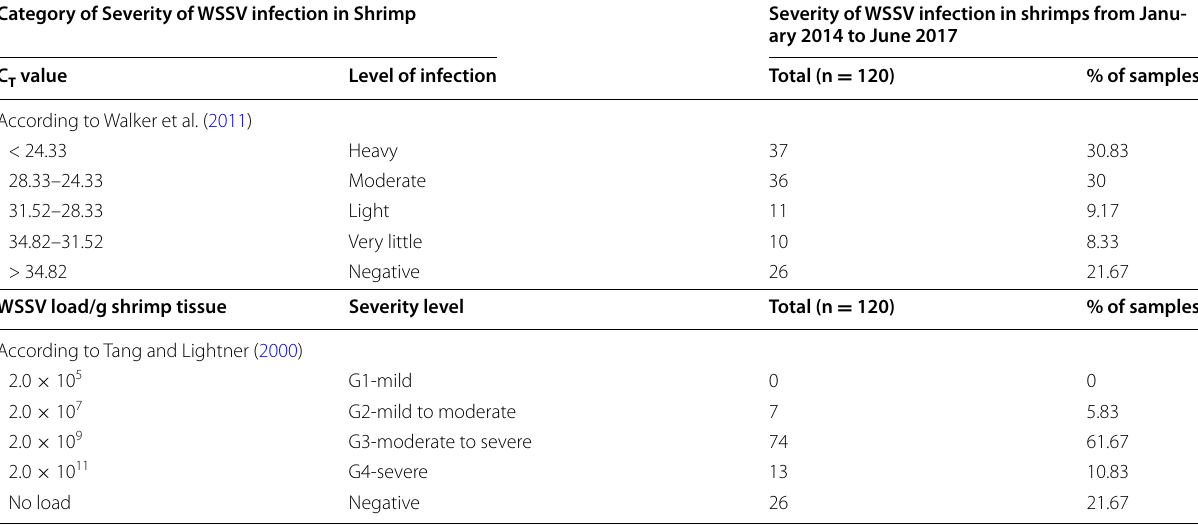
Table 1 The potential severity of WSSV infection in farmed shrimp was evaluated by the laboratory based severity study of Walker et al. (2011) and Tang and Lightner (2000) Category of Severity of WSSV infection in Shrimp